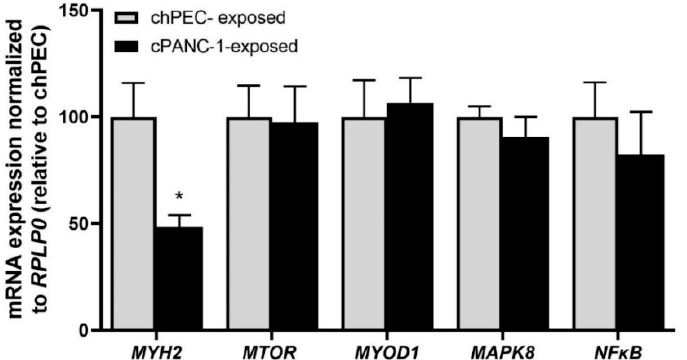
Figure 2. Expression of genes related to protein turnover in myotubes after conditioning with medium collected from hPECs or PANC-1 cells. Myotubes were conditioned with the medium from human pancreatic epithelial cells (chPEC exposed) or a human pancreatic cancer cell line (cPANC-1 exposed) during the last 4 days of differentiation. mRNA was isolated, and the expression of myosin heavy chain 2 ( MYH2 ), mechanistic target of rapamycin ( MTOR ), myoblast determination protein 1 ( MYOD1 ), mitogen-activated protein kinase 8 (MAPK8), and nuclear factor kappa B ( NF κ B ) was assessed. The expression of each gene was normalized for the expression of the housekeeping gene ribosomal protein lateral stalk subunit P0 ( RPLP0 ). Data are presented as the mean ± SEM from two individual experiments, with three replicates each ( n = 6) relative to expression in chPEC-exposed cells. * Statistically significant in cPANC-1-exposed myotubes versus chPEC-exposed myotubes ( p ≤ 0.05, unpaired t -test).